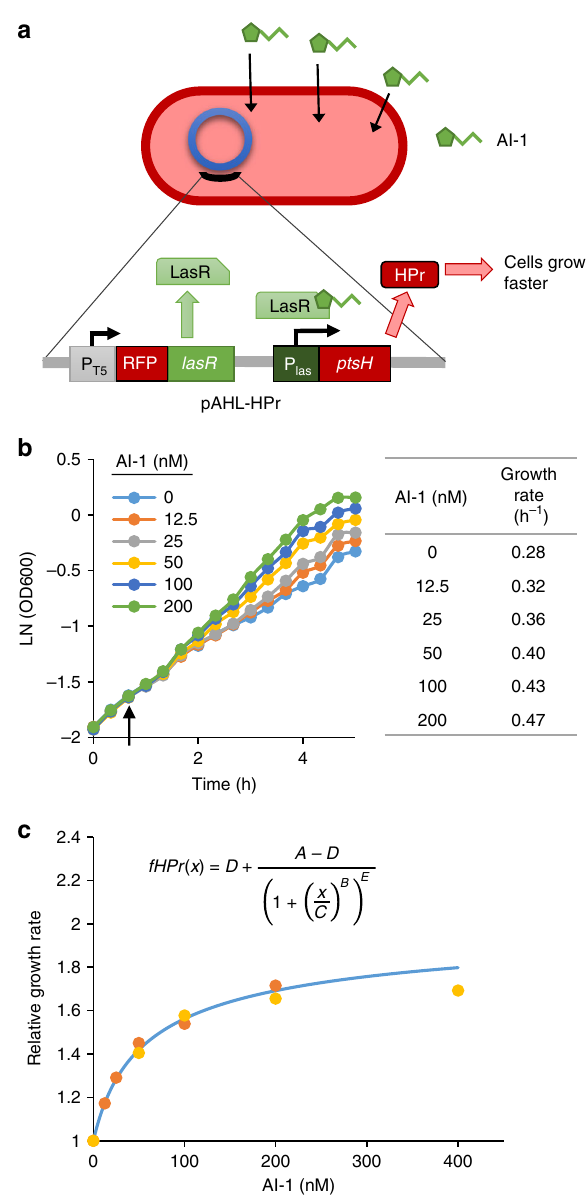
Fig. 2 AI-1 quorum sensing signal controlled growth rate through expression of HPr. a Schematic of AI-1 growth responsive controller cells (PH04 pAHL-HPr). AI-1 binds LasR (constitutively expressed) and activates the las promoter resulting in expression of HPr which increases cell growth rate. b Growth curves of PH04 pAHL-HPr cultures grown with varying levels of AI-1. Cultures were grown to OD 0.15 ( t = 0) and AI-1 was supplemented at 40 min (indicated by arrow). Table shows the average growth rate from 1 to 4 h after AI-1 addition. c Growth rate relative to basal growth rate (either 0.28 or 0.32 h − 1 ) for different AI-1 concentrations is plotted for two separate experiments (yellow and orange dots). Function fHPr describing relative growth rate as a function of AI-1 is plotted (blue line). A = 1, B = 1, C = 29, D = 2.1, E = 0.48. Source data are provided as